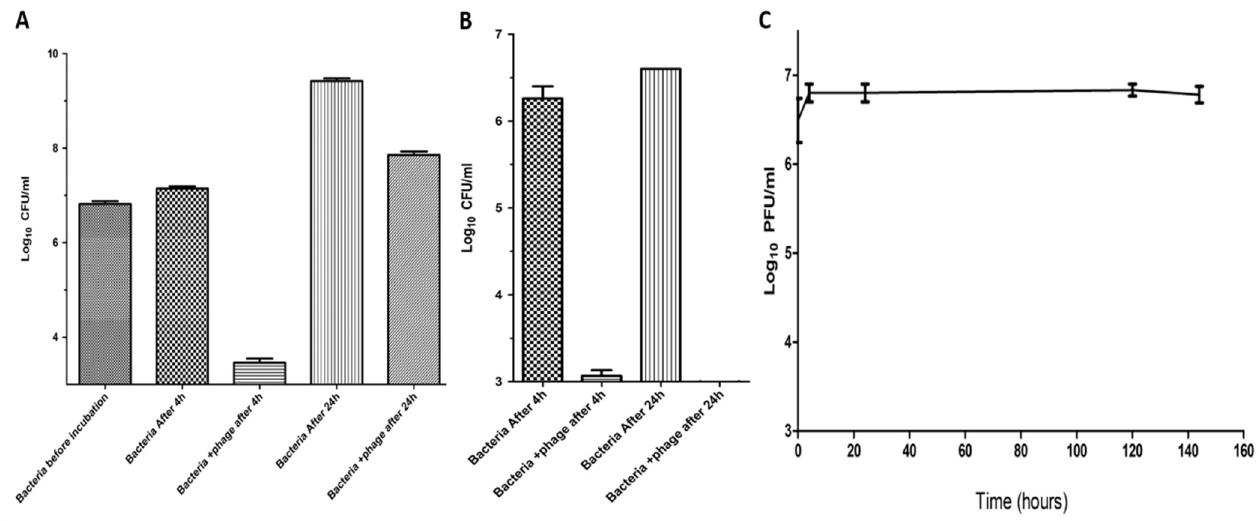
Figure 4. illustrates ( A ) the bacterial survivors in treated milk stored at 25 °C after 4 and 24 h; ( B ) bacterial survivors in treated milk stored at 4 °C after 4 and 24 h; and ( C ) the phage stability in Salmonella milk-free over 6 days of incubation at 4 °C.